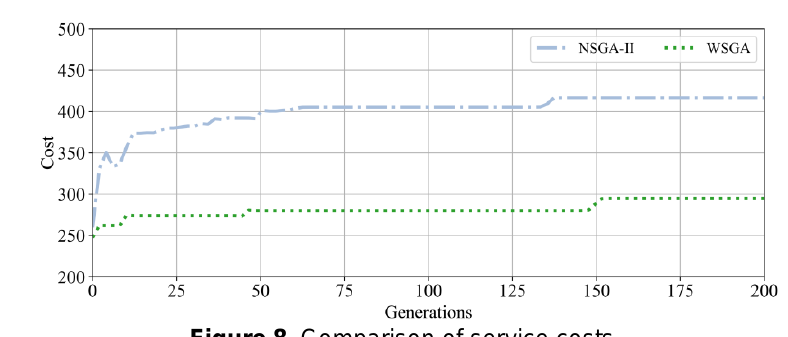
Figure 8 . Comparison of service costs